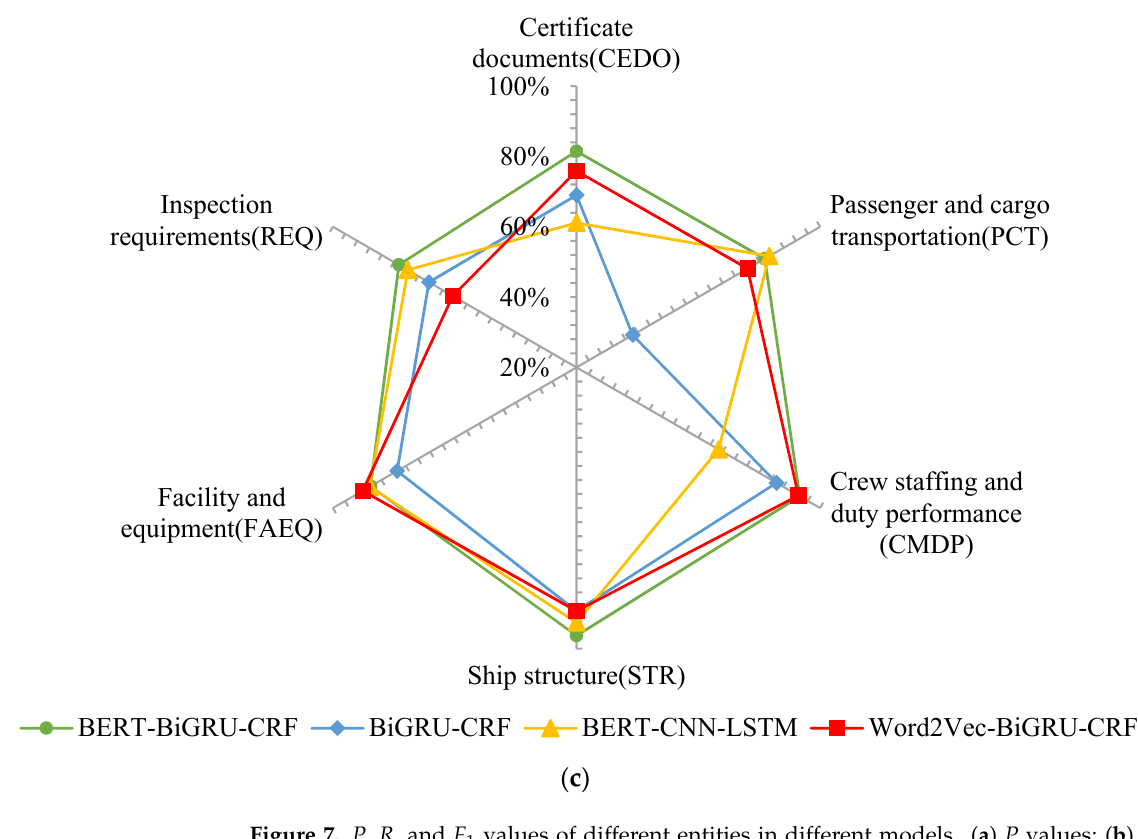
Figure 8. Ship FSC inspection knowledge graph (part).